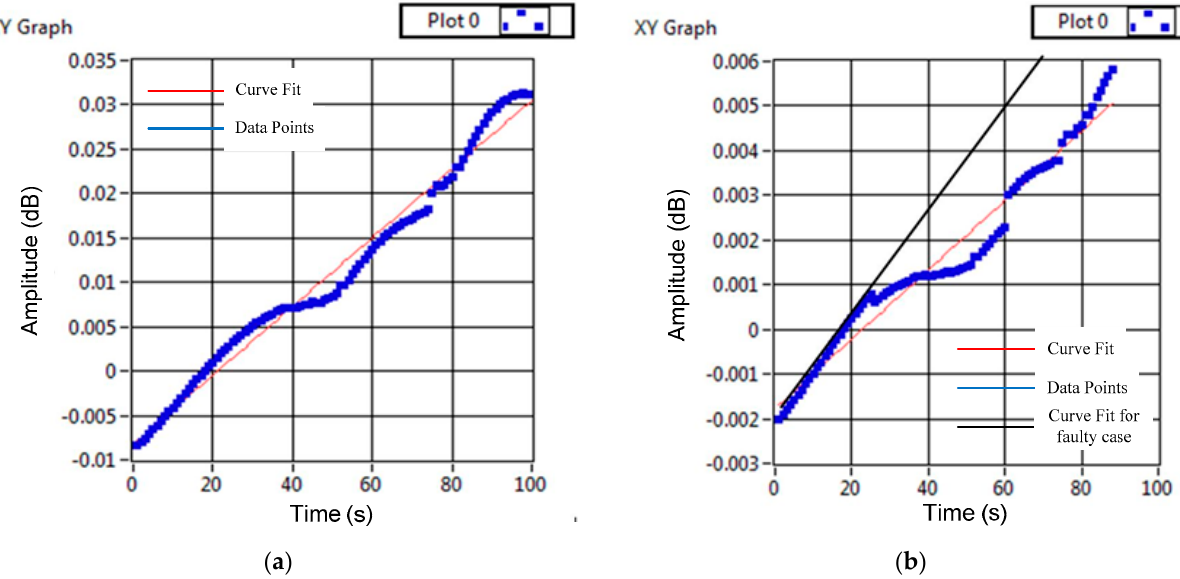
Figure 13. ANN-based pattern recognition diagram for the detection of broken rotor bars using the stator current for SCIM: ( a ) With broken rotor bars and ( b ) without broken rotor bars.